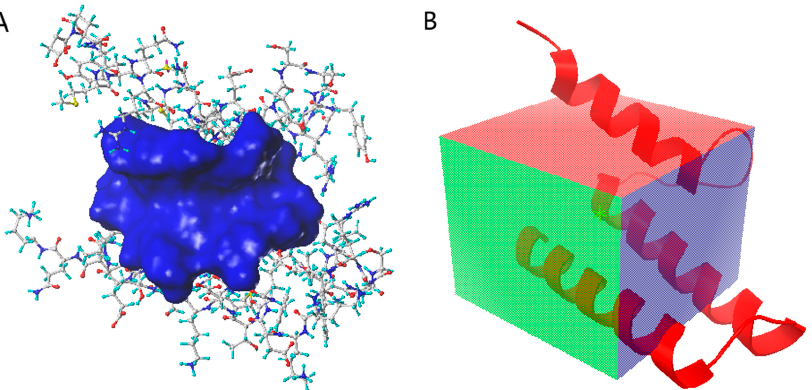
Figure 2. ( A ) The docking pocket for SYBYL and Discovery Studio programs, blue: pocket; stick: protein; ( B ) the docking pocket for AutoDock Vina software, box: pocket; red: protein.